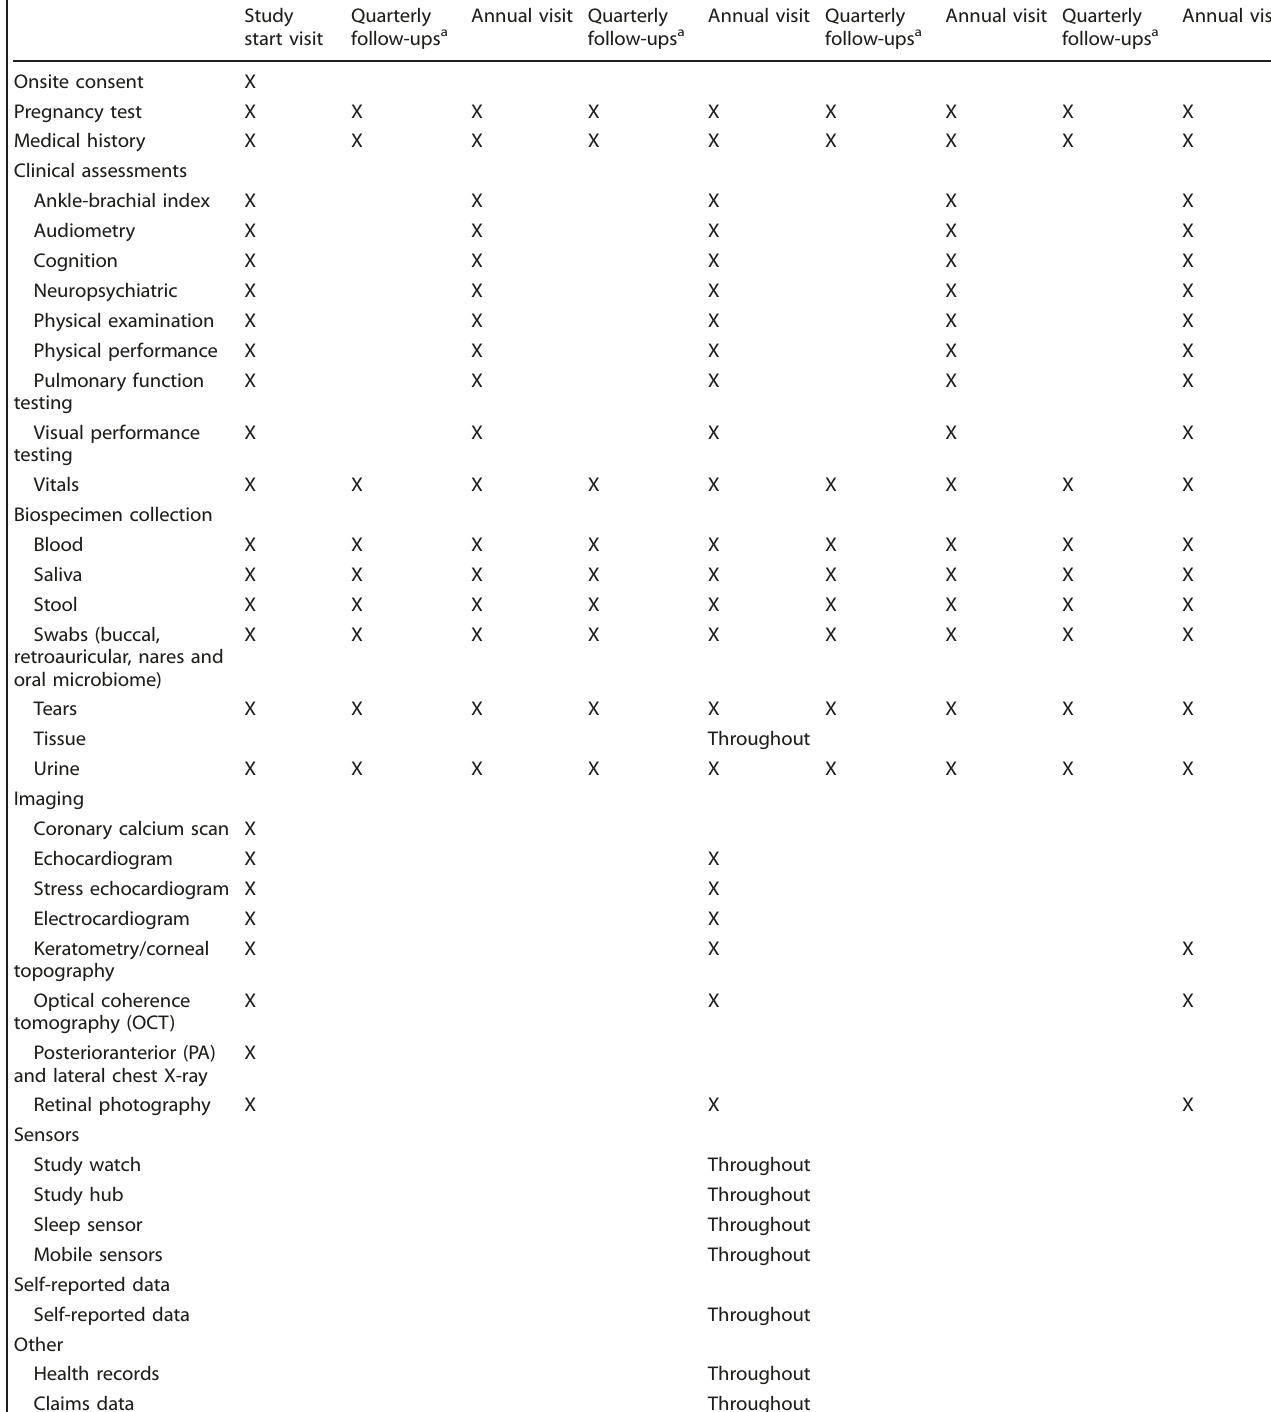
Table 2. Study data